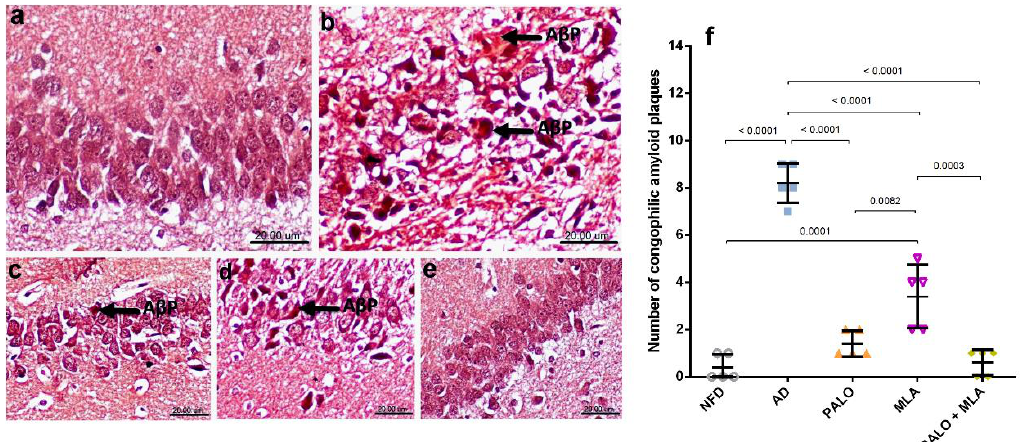
Figure 9. Effects of PALO and/or MLA on CA1 hippocampal histopathological examination of amyloid plaques in HFFD/LPS-induced AD model. Photomicrograph of Congo red stained sections from CA1 region of hippocampus of rats in ( a ) NFD shows the normal histology of neuronal cells with no deposition of amyloid β plaques (AβP). Section of ( b ) AD model shows multiple intracellular and extracellular deposition of AβP; meanwhile, sections of the ( c ) PALO treated group shows mild deposition of these plaques. Sections of the ( d ) MLA treated group shows multifocal moderate intracellular deposition of AβP, the section of ( e ) PALO + MLA shows no deposition of AβP (Scale bar 20μm, ×600). Panel ( f ) represents the number of congophilic AβP counted in 5 random non-overlapping microscopic field ( ×600) in each section. Data were analyzed using one-way ANOVA followed by Tukey ’ s post hoc test; p < 0.05. PALO (0.1 mg·kg −1 ; i.p) and/or MLA (5.6 mg·kg −1 ; i.p) were administered 3 h after LPS injection and for 8 days.